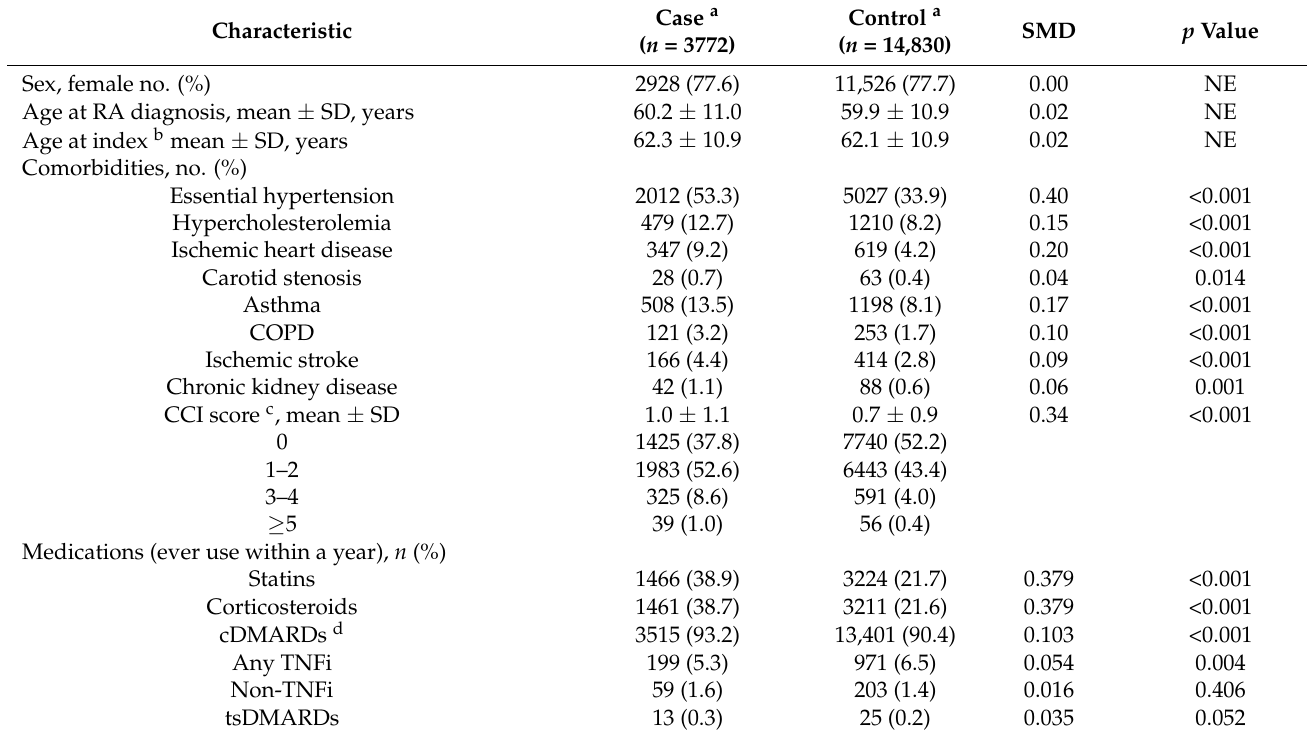
Table 1. Clinical characteristics of cases and